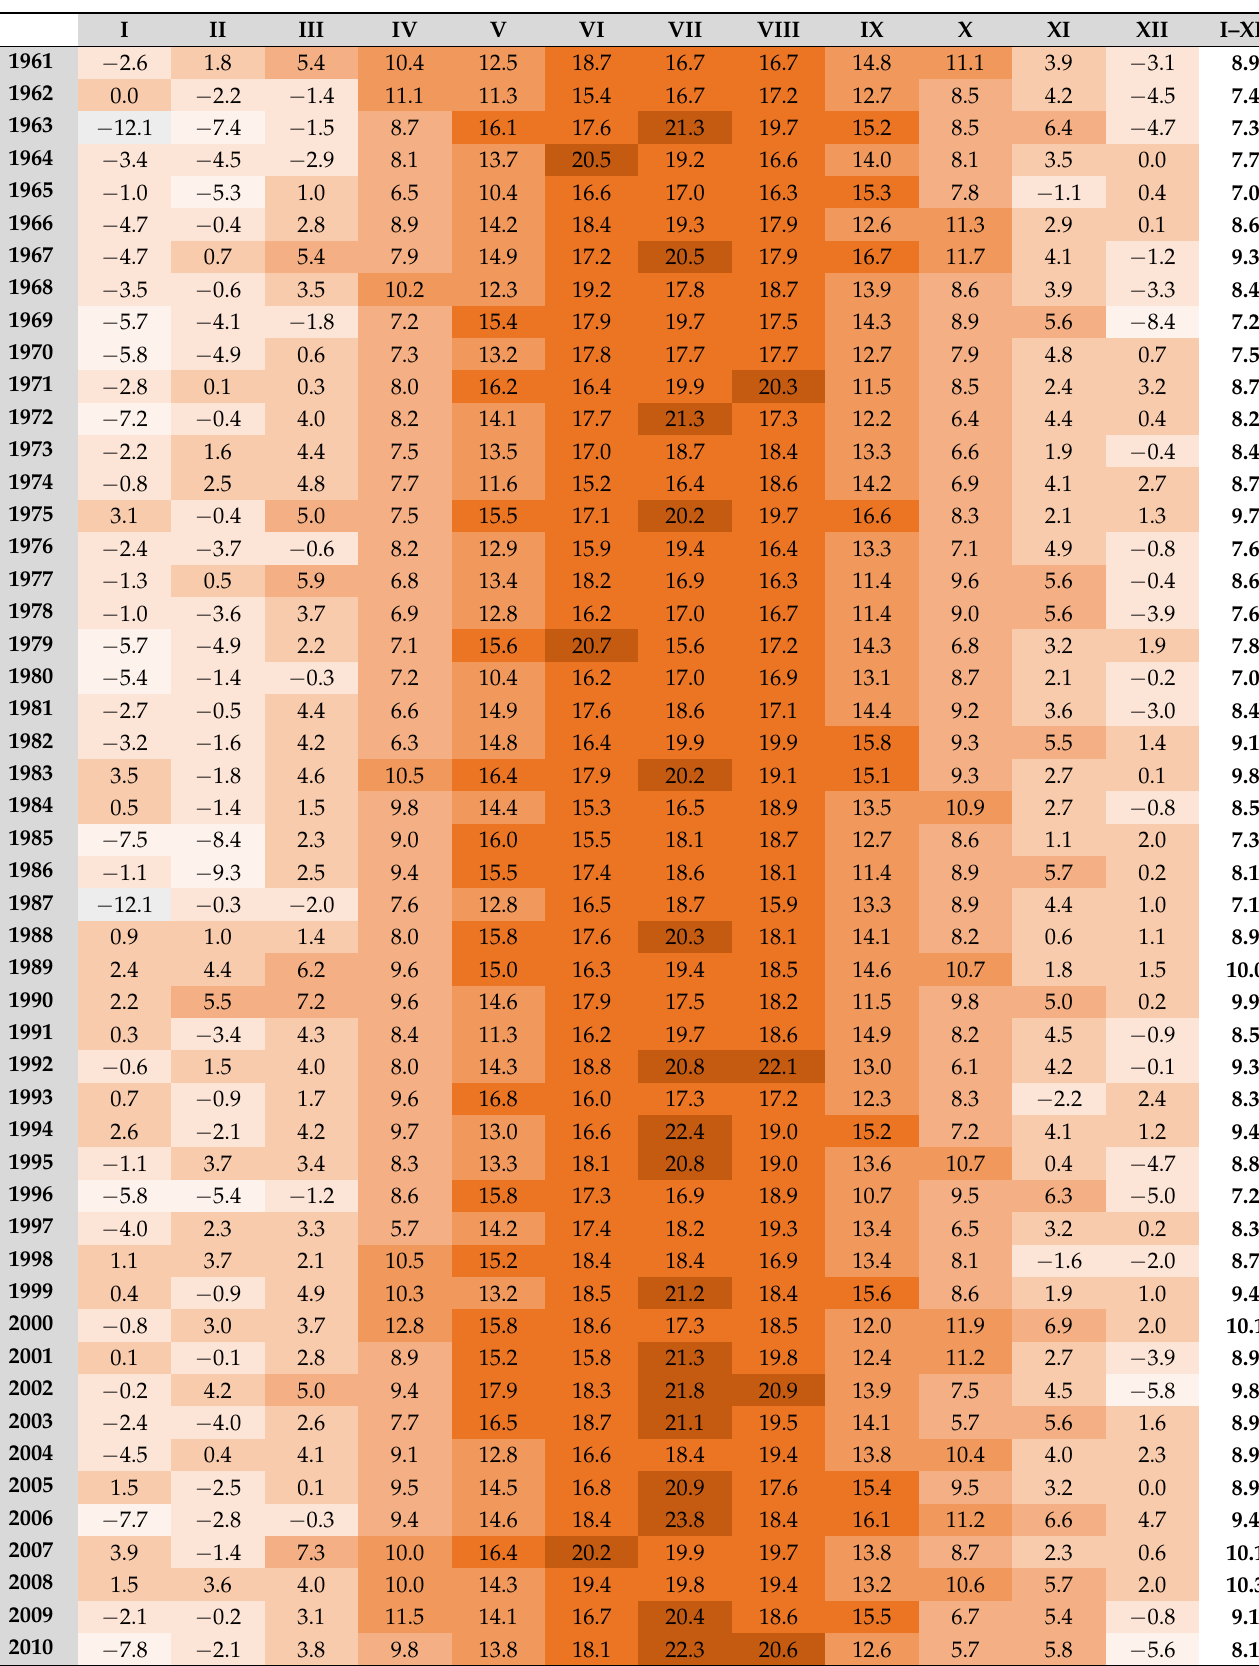
Table 1. Monthly average temperature from 1961 to 2020 in